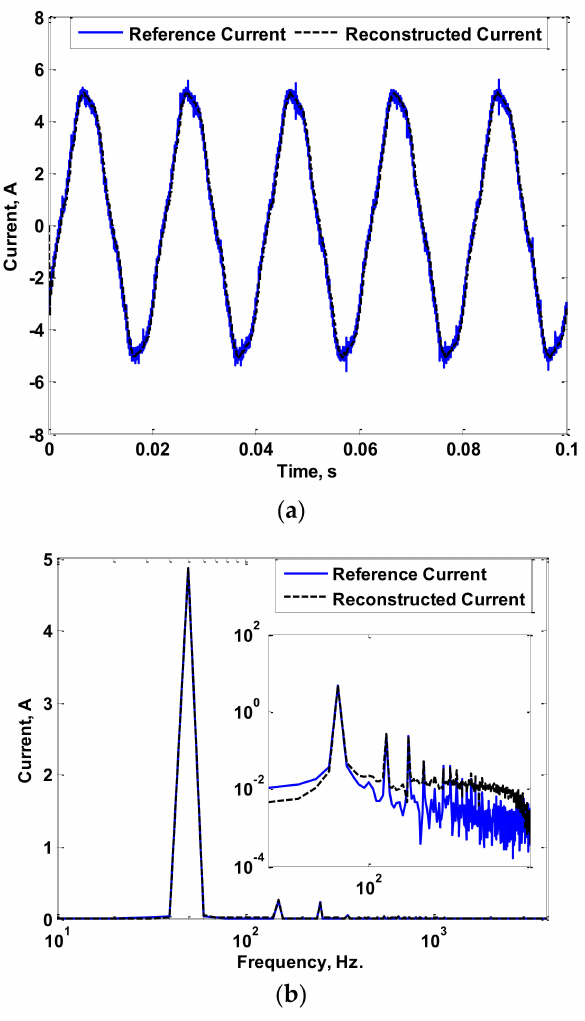
Figure 15. Reference and Reconstructed Currents of a 600 W luminaire: ( a ) Reference and Recon- structed Current Waveforms; ( b ) FFT of Reference and Reconstructed